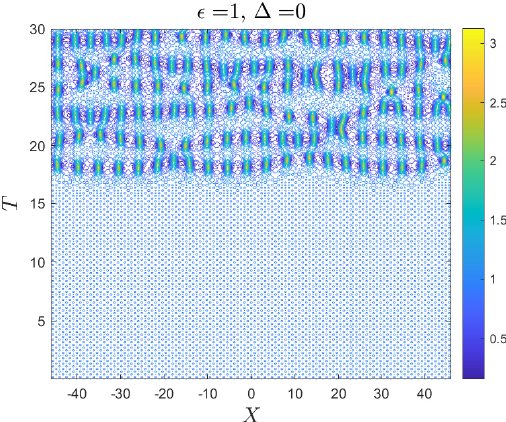
Figure 17. Case 4: The initial condition is (14) with (cid:101) = 1.0, M = 1, K = 4 and ∆ =